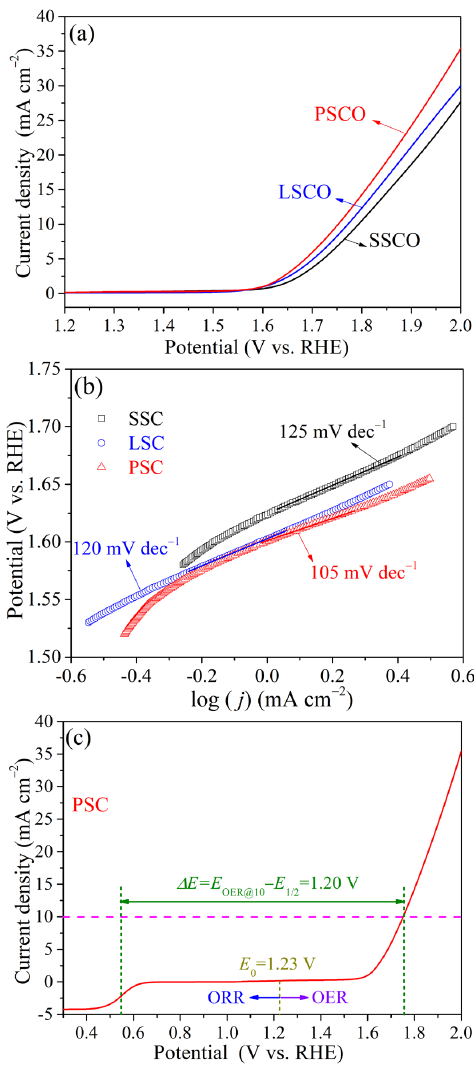
Figure 5. ( a ) OER polarization curves on various catalysts in O 2 -saturated 0.1 M KOH at 1600 rpm with a scan rate of 10 mV s −1 and ( b ) corresponding Tafel plots derived from LSV polarization curves; ( c ) Overall polarization curves in the full OER/ORR region of PSC in O 2 -saturated 0.1 M KOH.